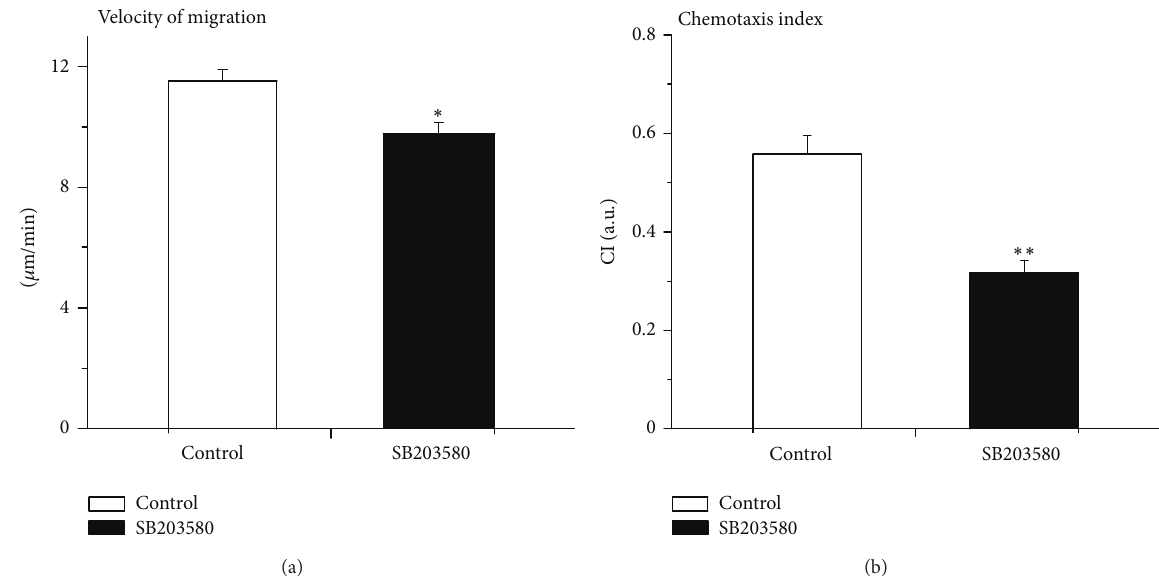
Figure 6: Effect of SB203580 on KC-induced neutrophil migration and chemotaxis. (a) The velocity of neutrophil migration in response to KC stimulation in the absence (control, white) and in the presence (black) of p38 MAPK inhibitor SB203580 (100nM) 30 min following the placement of KC-containing gel. Data are means ± SEM ( 𝑛 = 5 ). ∗ indicates significant difference ( 𝑃 < 0.05 ) from the control without SB203580 ( t -test). (b) The chemotaxis index (CI) in response to KC stimulation in the absence (control, white) and in the presence (black) of p38 MAPK inhibitor SB203580 (100nM) 30 min following the placement of KC-containing gel. Data are means ± SEM ( 𝑛 = 5 ). ∗∗ indicates significant difference ( 𝑃 < 0.01 ) from the control without SB203580 ( t